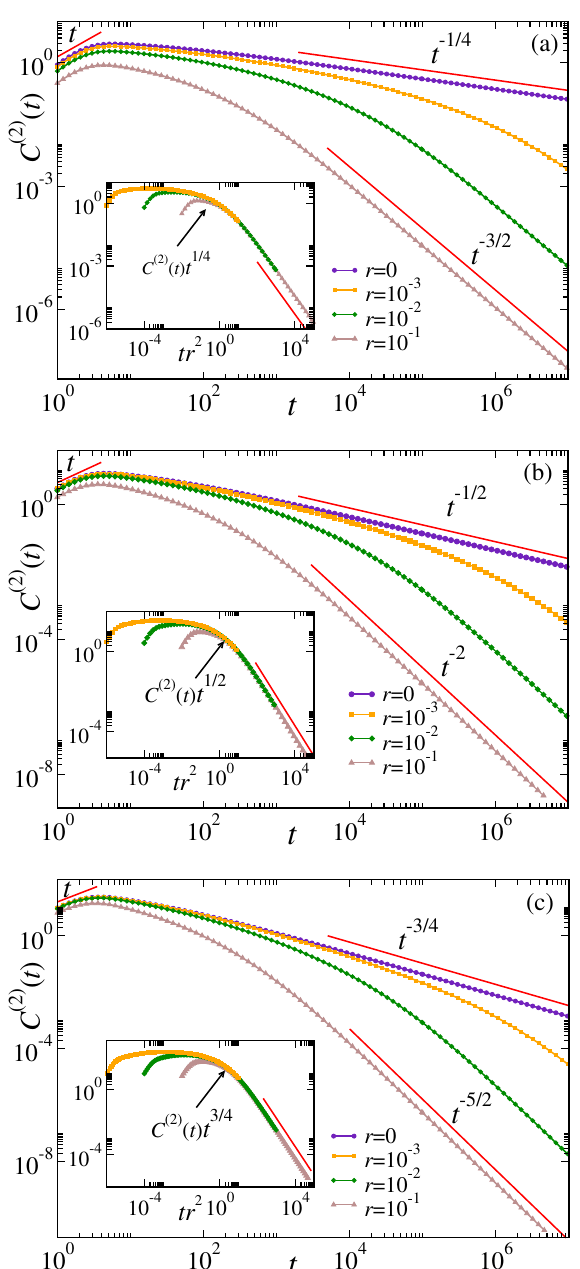
Figure 2: Stationary auto-correlation function C ( 2 ) ( t ) of the position of the colloidal particle, as obtained numerically in spatial dimension (a) d = 1, (b) 2, and (c) 3, for various values of the parameter r which controls the spatial and temporal extents of the correlations of the fluctuations within the medium. At the critical point r = 0, the correlation C ( 2 ) ( t ) decays as t − d / 4 at long times, while away from the critical point C ( 2 ) ( t ) ∼ t − ( 1 + d / 2 ) . These slow algebraic decays — indicated in the various panels by the straight lines on the right — determine that of the total auto-correlation function C ( t ) , as the contribution of order λ 0 decays exponentially upon increasing time. At short times, instead, C ( 2 ) ( t ) turns out to grow linearly upon increasing t , as indicated by the solid lines on the left of each panel and as discussed, c.f., in Sec. 4.6. The insets ( t ) when the same data is plotted as a function of show the scaling collapse of t d / 4 C 2 t r 2 . Here we considered an interaction potential V ( z ) = e − z 2 / ( 2 R 2 ) with R = 2 and = D = T = 1 and κ = γ 0